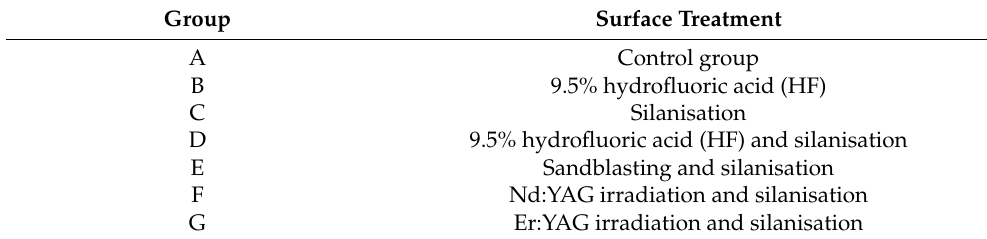
Table 1. Groups based on surface